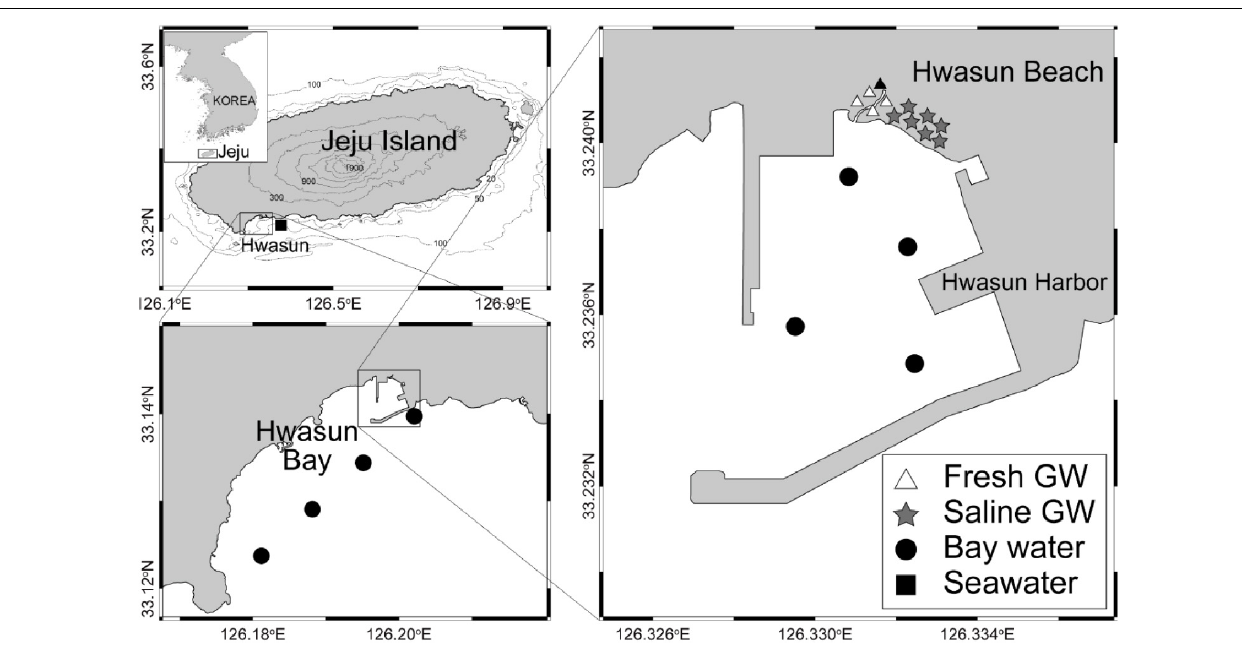
FIGURE 1 | Maps showing study area and sampling stations for fresh and saline groundwater, bay water, and seawater.